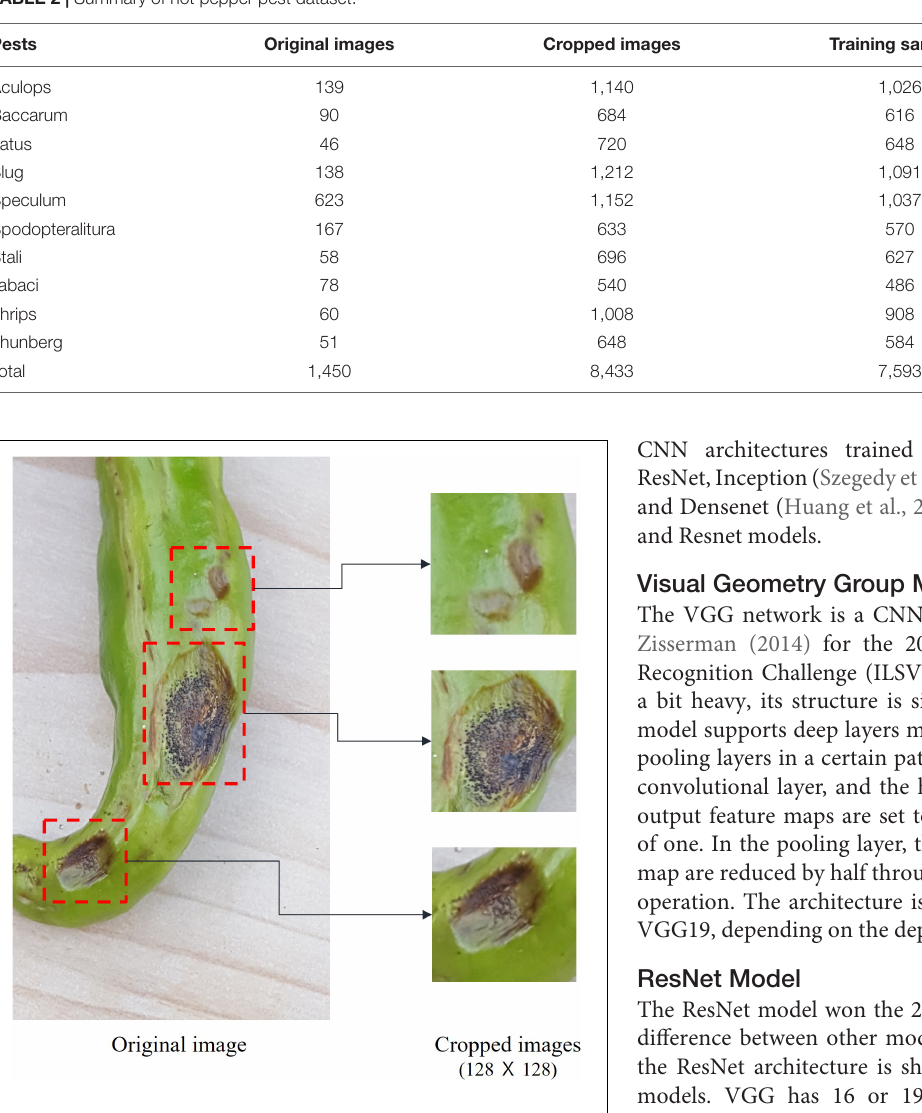
FIGURE 2 | The process of image